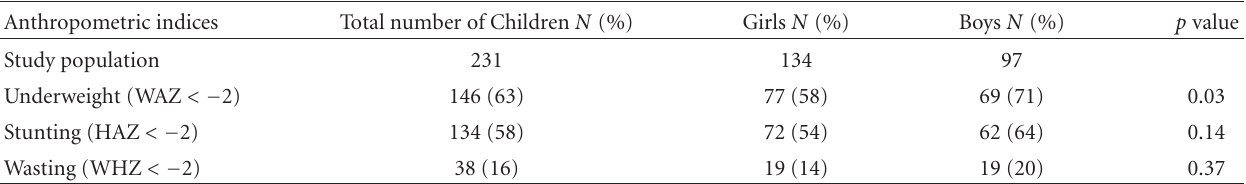
Table 2: Gender wise prevalence of malnutrition among HIV-infected Children.